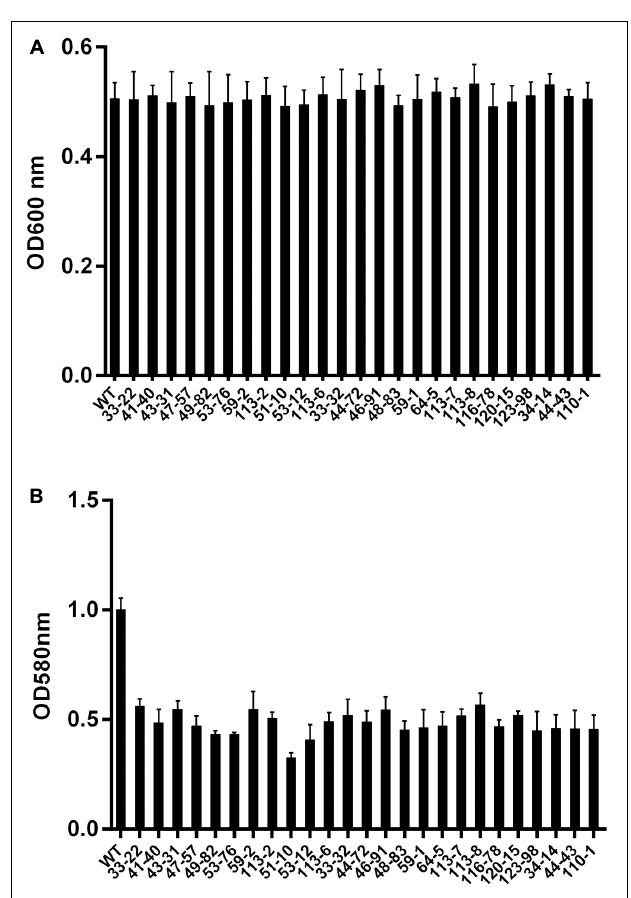
FIGURE 5 | The biofilm forming ability of A. actinomycetemcomitans transconjugants. (A) Culture density of biofilm deficient mutants following overnight incubation at 37 ◦ C in an atmosphere with 5% CO 2 . (B) Fold differences in biomass in biofilm deficient transconjugants. Mutants were picked and cultured in 96-well polystyrene plates for 24 h, and the biomass of mutants were determined by crystal violet assay. WT: wild-type strain A. actinomycetemcomitans